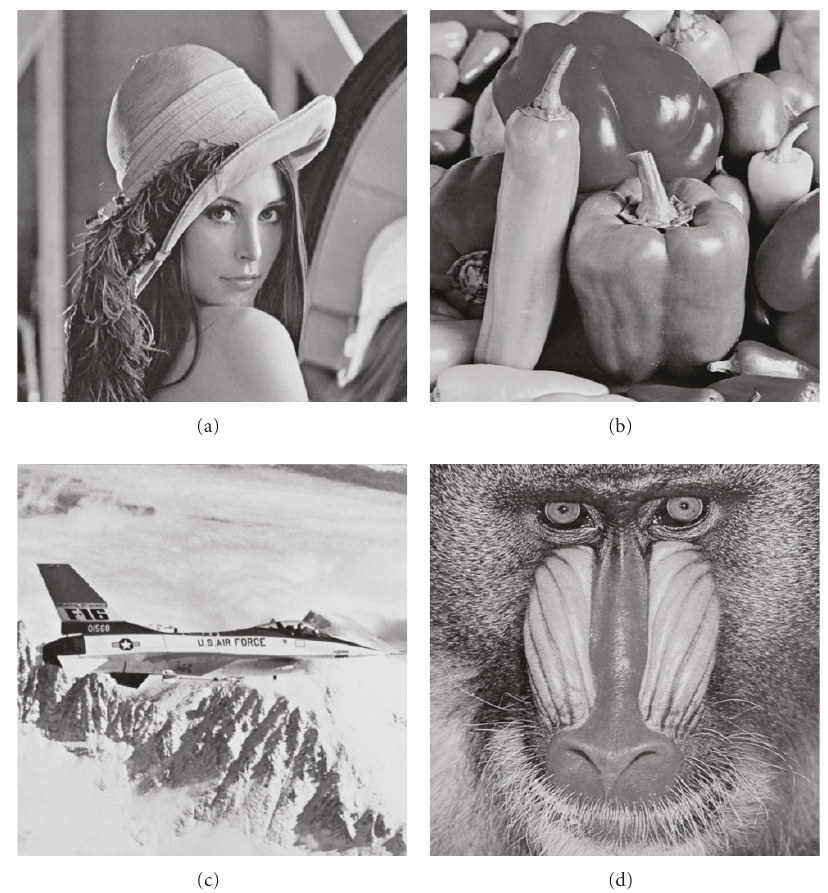
Figure 14: Four images for experiments: (a) Lena, (b) Pepper, (c) Airplane, and (d)